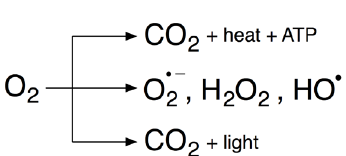
Figure 8 - Biological functions of molecular oxygen in luminescent beetles: mitochondrial respiration to conserve energy as ATP; production of oxyradicals (superoxide and hydroxyl radicals) and H O , involved in oxidative damage 2 2 and cell signaling (redox control); and